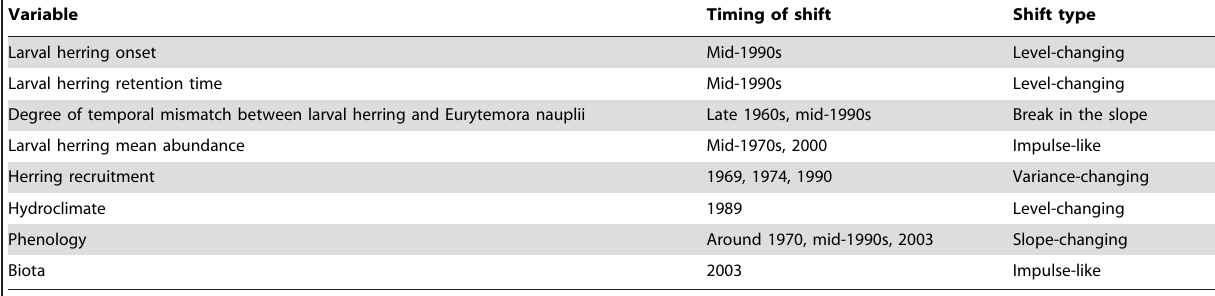
Table 2. Timing and types of